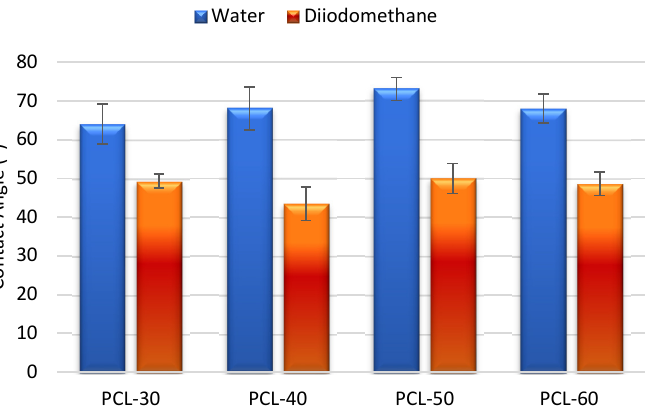
Figure 3. Quantifying the contact angles of SPTURs.